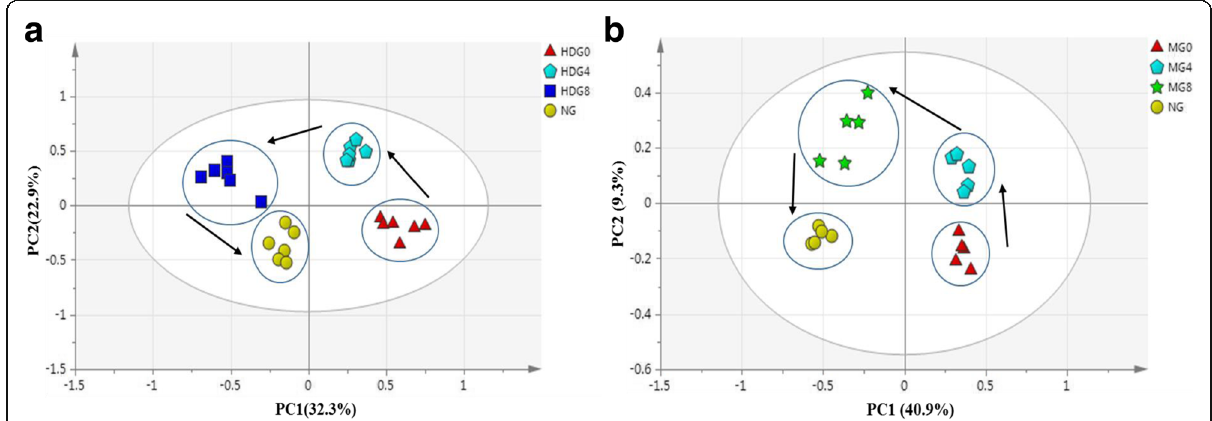
Fig. 9 OPLS-DA score plot of ( a ) ML and ( b ) metformin obtained using 1 H NMR data for serum samples from Sprague-Dawley rats, normal diet group (NG), week0 (HDG0 and MG0), week4 (HDG4 and MG4) and week8 (HDG8 and MG8) of treatment